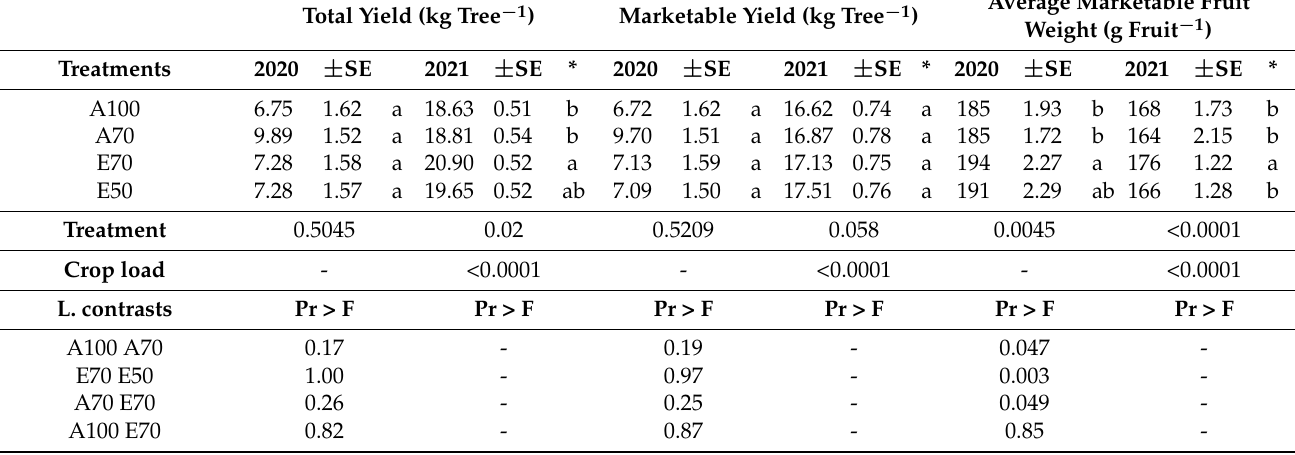
Table 3. Total and marketable yields and average marketable fruit weight, measured at harvest, during years 2020 and 2021, followed by standard error and letters, indicating statistical significance at 95% when different, according to a SNK test. For 2021 results, * indicates significantly different crop load among treatments; thus, each value is the LS means of an ANCOVA (mean of nine trees). In the lower part of the table, treatment, crop load and linear contrast F values for each year are shown; values below 0.05 are considered significant. Linear contrasts are not reported where crop load significantly impacted harvest